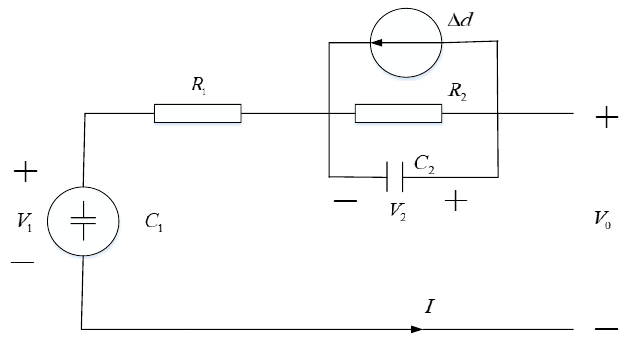
Figure 1. RC equivalent circuit diagram of Li-ion batteries.